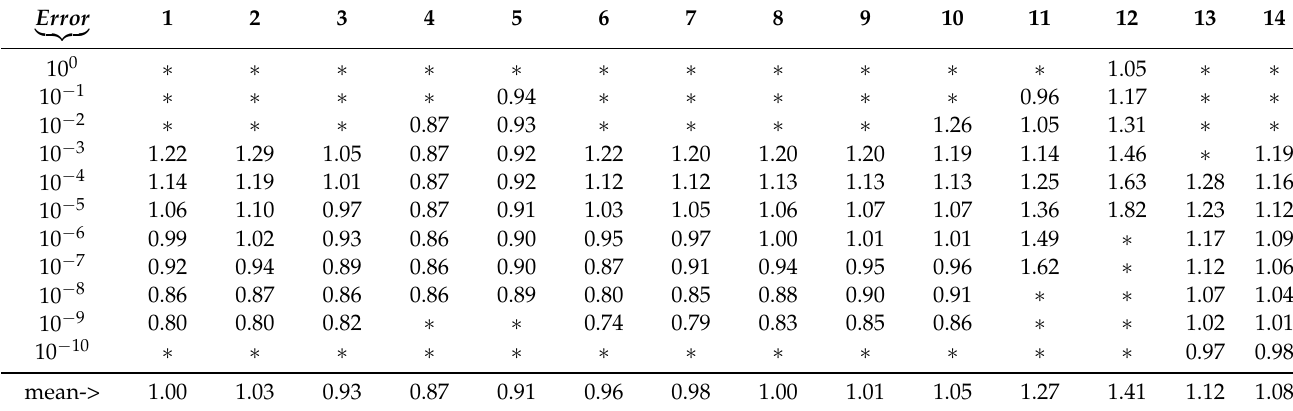
Table 4. Efficiency ratios of DP5(4) vs. T5(4) for various problems and end-point errors achieved. Stars indicate unavailability of data to attain the perspective